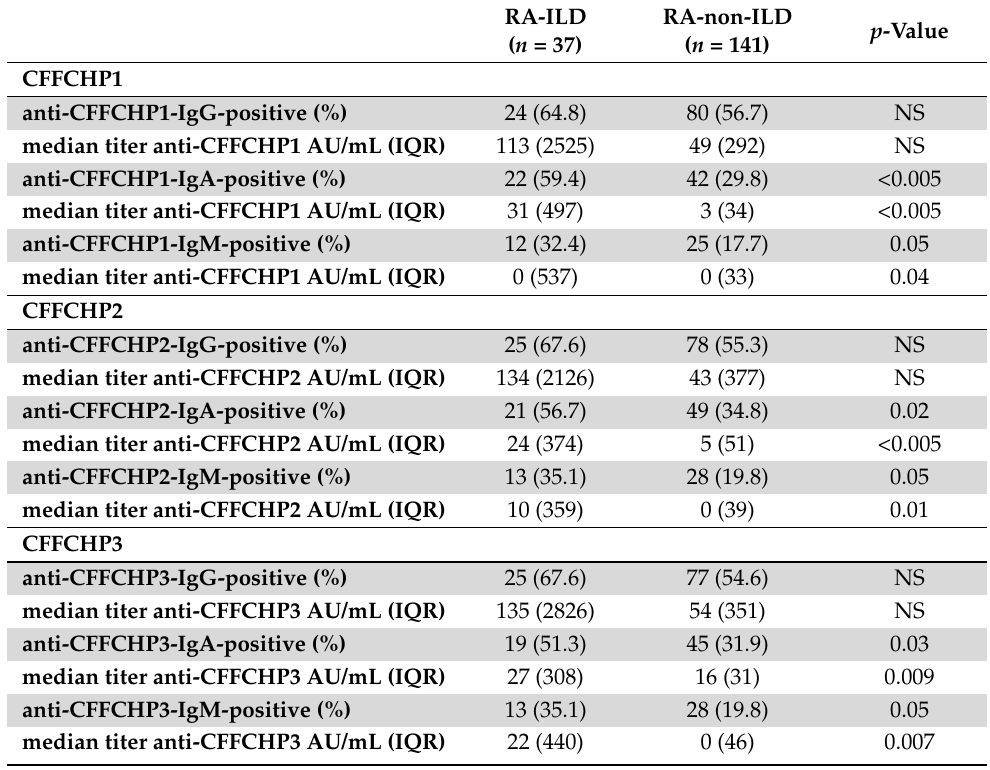
Table 2. Autoantibody status in RA patients (ILD vs. non-ILD).